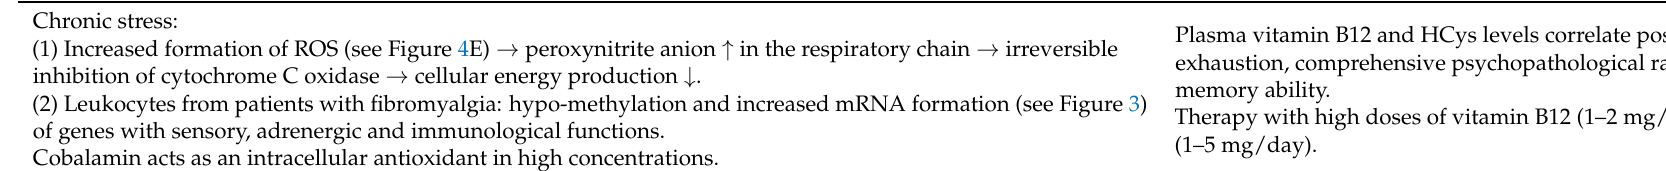
Table A12. Chronic fatigue syndrome, fibromyalgia— Rev